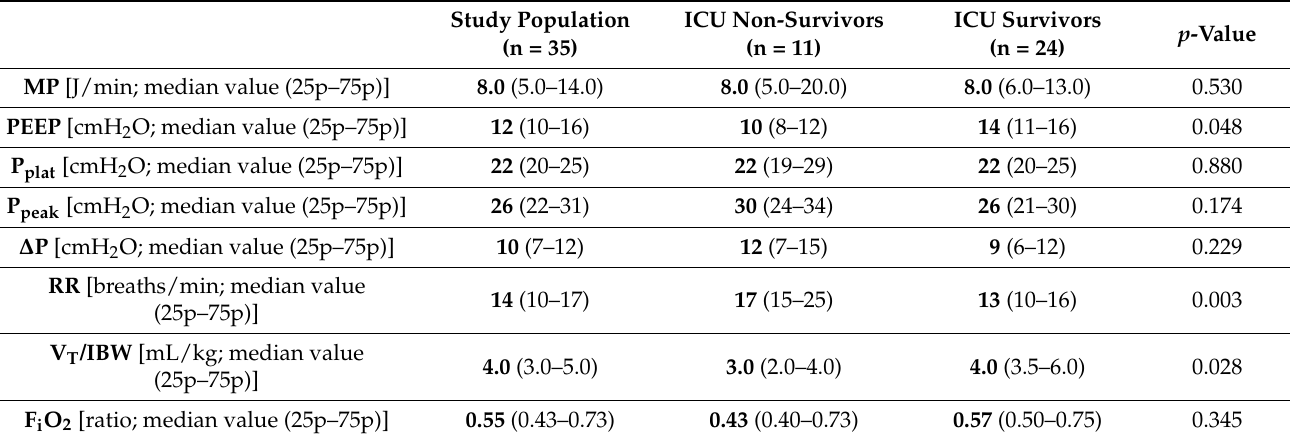
Table 3. Comparison of MV parameters during the first quartile of VV ECMO length, according to the ICU mortality. [MV mechanical ventilation, VV ECMO veno-venous extracorporeal membrane oxygenation, ICU intensive care unit, MP mechanical power, PEEP positive end-expiratory pressure, P plat plateau pressure, P peak peak pressure, ∆ P driving pressure,